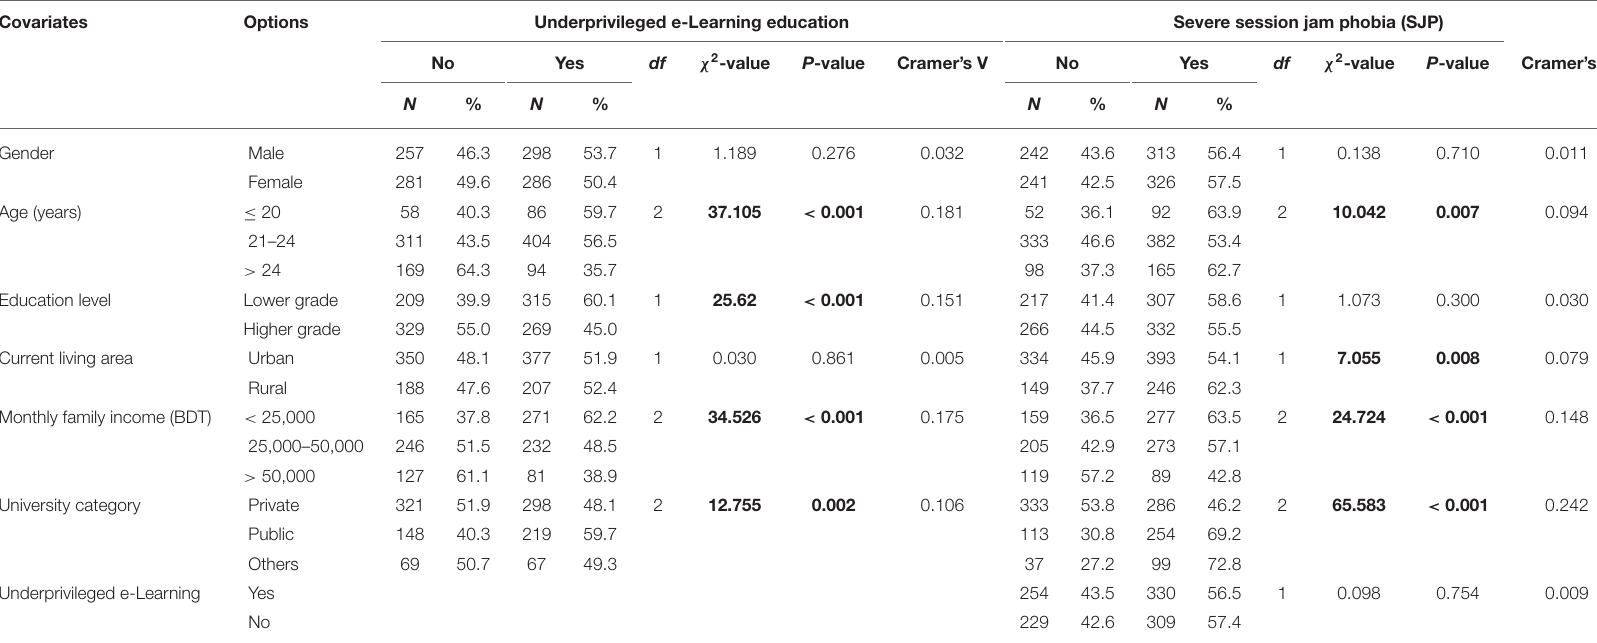
TABLE 1 | Chi-square ( χ 2 )-test for evaluating the association of different factors with underprivileged education and severe session jam phobia (SJP) among university students following extended COVID-19 shutdown in Bangladesh.